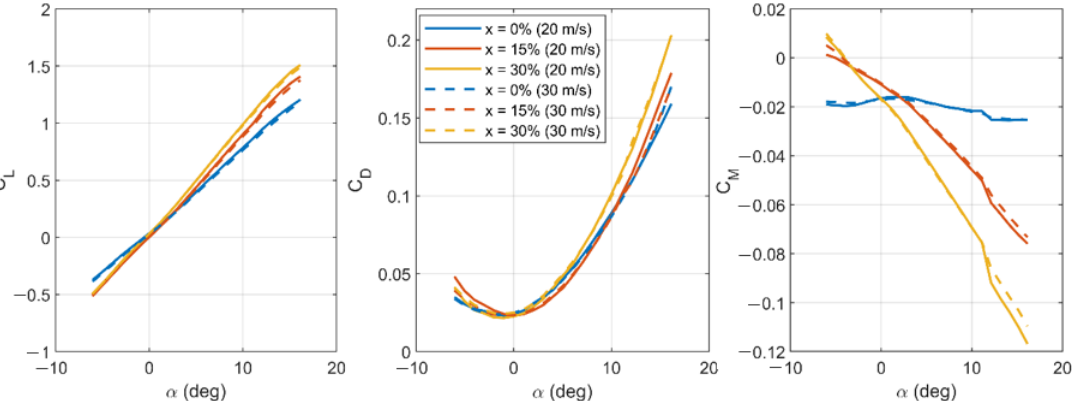
Figure 15. Results for the lift (CL), drag (CD), and pitching moment (CM) coefficients of the wind tunnel test at 20 m/s and 30 m/s with an angle of attack sweep from − 5 ◦ to 15 ◦